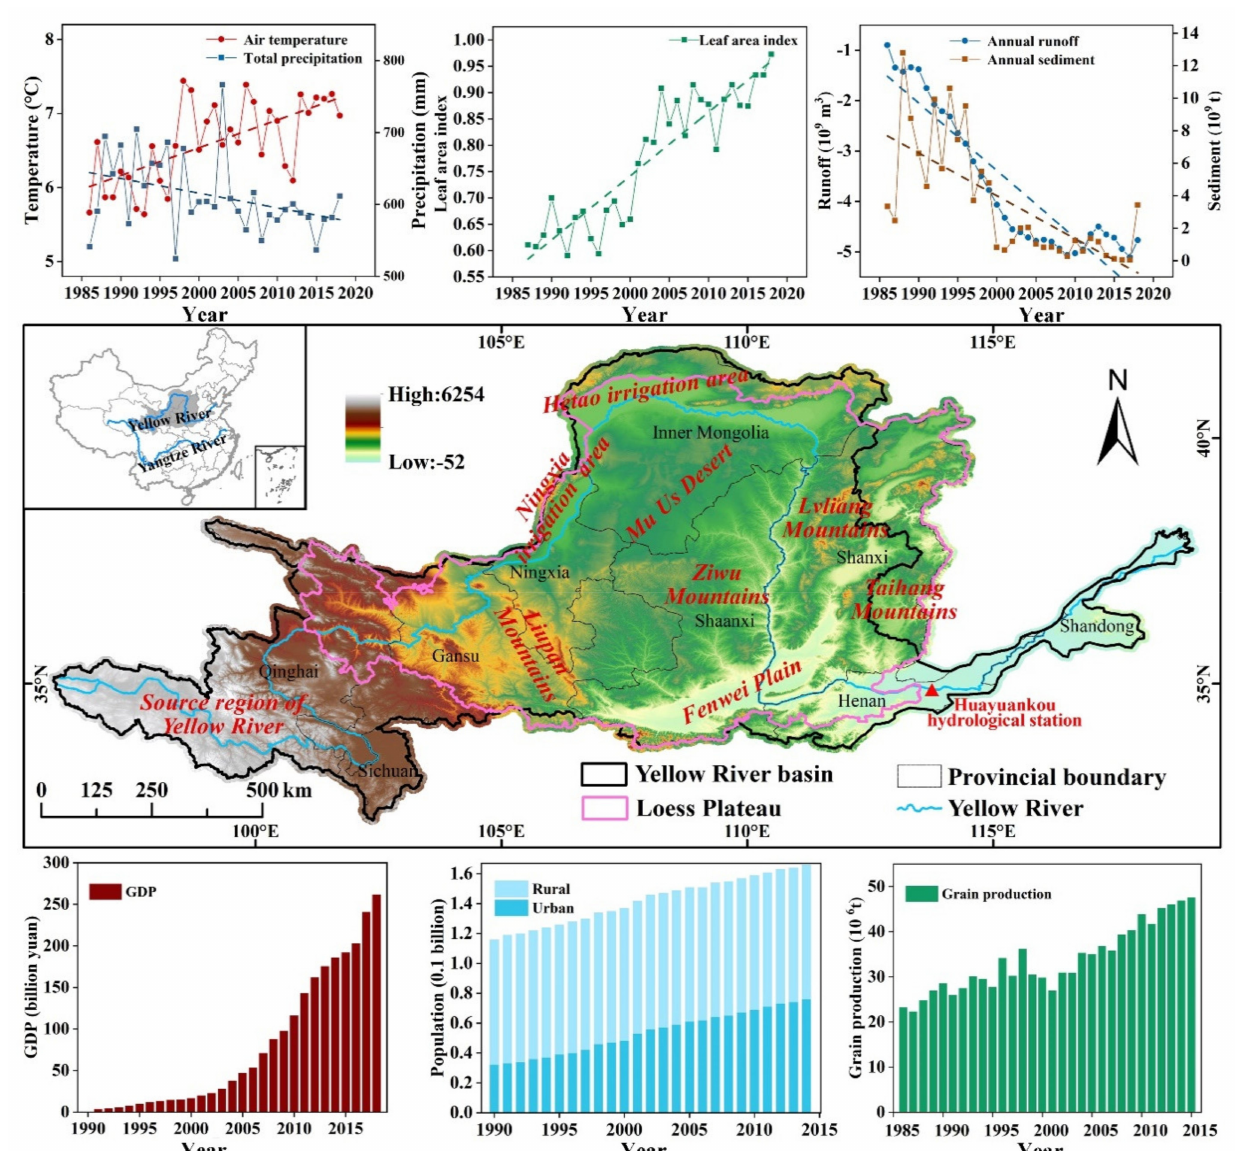
Figure 1. Location of the Yellow River basin and the Loess Plateau. The data source of average temperature and the average total precipitation of the study area is ERA5 (the fifth generation European Centre for Medium-Range Weather Forecasts atmospheric reanalysis of the global climate). The data source of the average leaf area index of the study area is AVHRR (Advanced Very High-Resolution Radiometer). The total runoff and total sediment data are from the statistical data of the Huayuankou hydrological station (the boundary between the middle and lower reaches of the YR). The data of the regional sum of Gross Domestic Product (GDP), population, and grain production come from the statistical